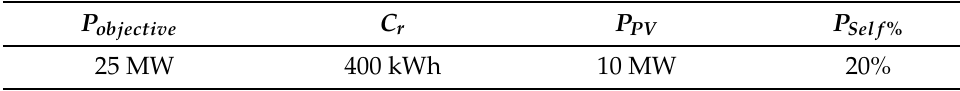
Table 5. Scenarios common parameters.